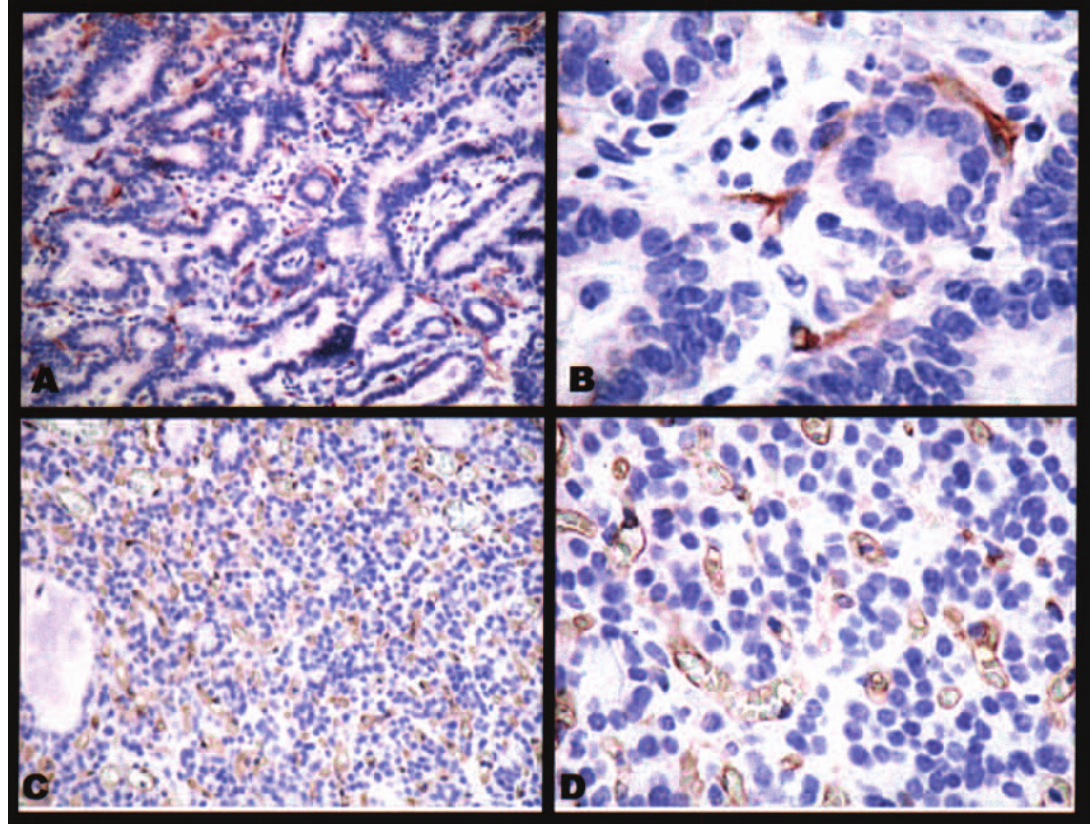
Figure 2 – The CD34 antibody expression in classic papillary carcinoma subtype, at 40X (A) and 400x (B) magnification; and in follicular one, at 40x (C) and 400x (D) magnification showing the higher number of microvessels in follicular papillary carcinoma